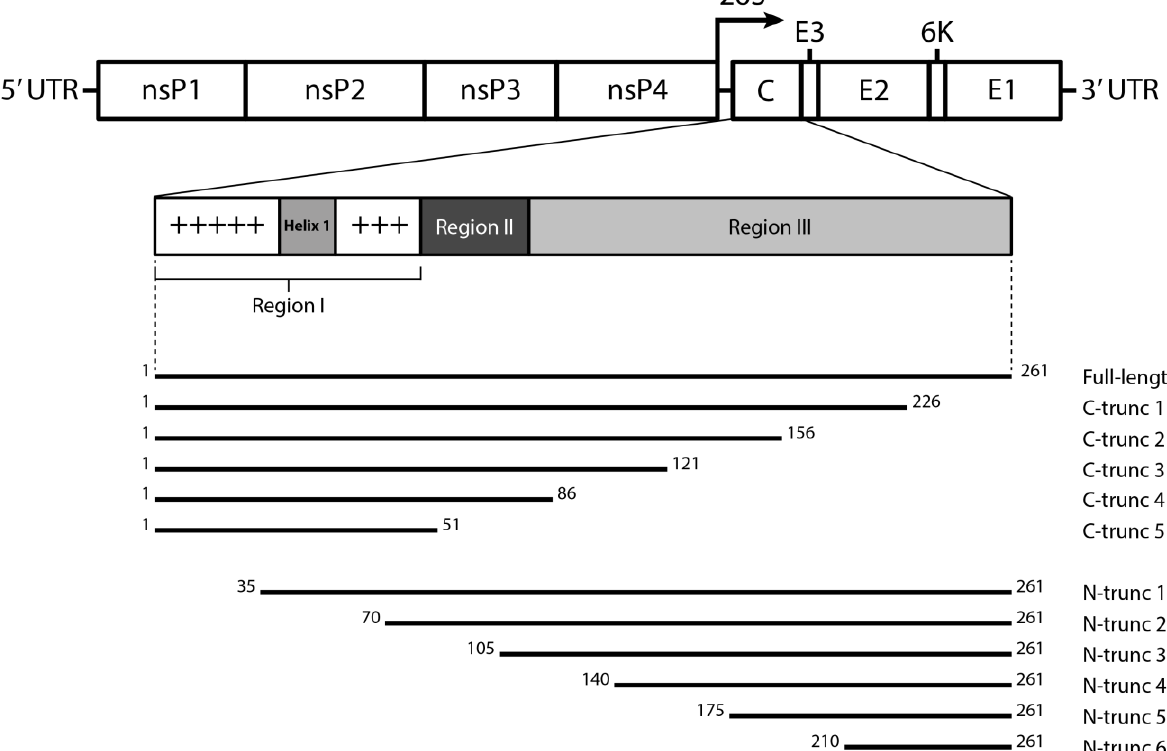
Figure 1. Schematic representation of the alphavirus capsid protein (CP) and the design of N - and C -terminal truncations in recombinant chikungunya virus (CHIKV) CP. The alphavirus CP is segmented into three separate regions, based on the prototype Sindbis virus (SINV) CP model—adapted from Hong et al. [20]. Region I has a high degree of positive charge associated with non-specific binding of the genomic viral RNA. Located within the same region, Helix 1, a sequence of uncharged amino acids, is suggested to be involved in the interactions during nucleocapsid core formation and its stabilization. Region II contains the minimum sequence required for specific RNA binding, while the C -terminal protease domain (region III) forms capsomeres in the nucleocapsid core and interacts with the E2 glycoprotein. The bottom part of the figure depicts the locations of the C - or N -terminal truncations within the full-length CP. Truncations were made in 35-amino acid increments.